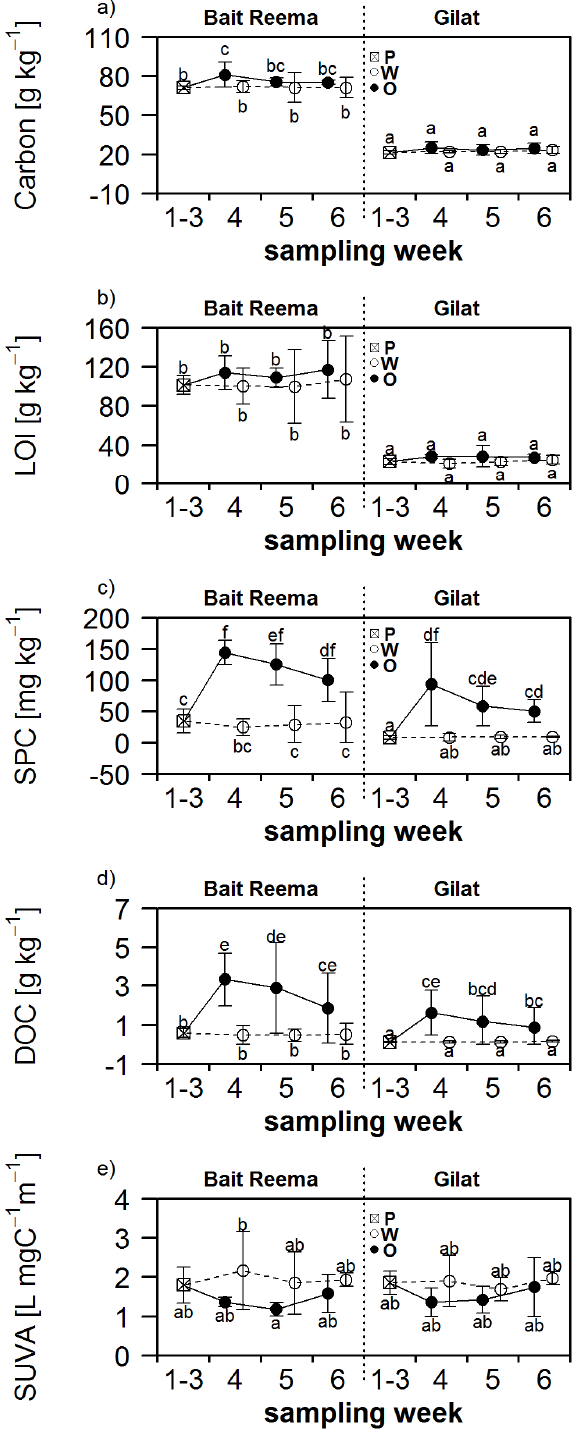
Figure 4. Evolution of soil carbon content, loss on ignition (LOI), soluble phenolic content (SPC), dissolved organic carbon (DOC) and specific UV-adsorption at 254 nm (SUVA 254 nm ) following amendment with OMW and water during six weeks of sampling in Bait Reema and Gilat. P, data before the application (were averaged after finding no statistical differences between three sampling weeks); W, water application; O, OMW application. Mean values followed by the same letter are not statistically different. Error bars show ±95 % confidence